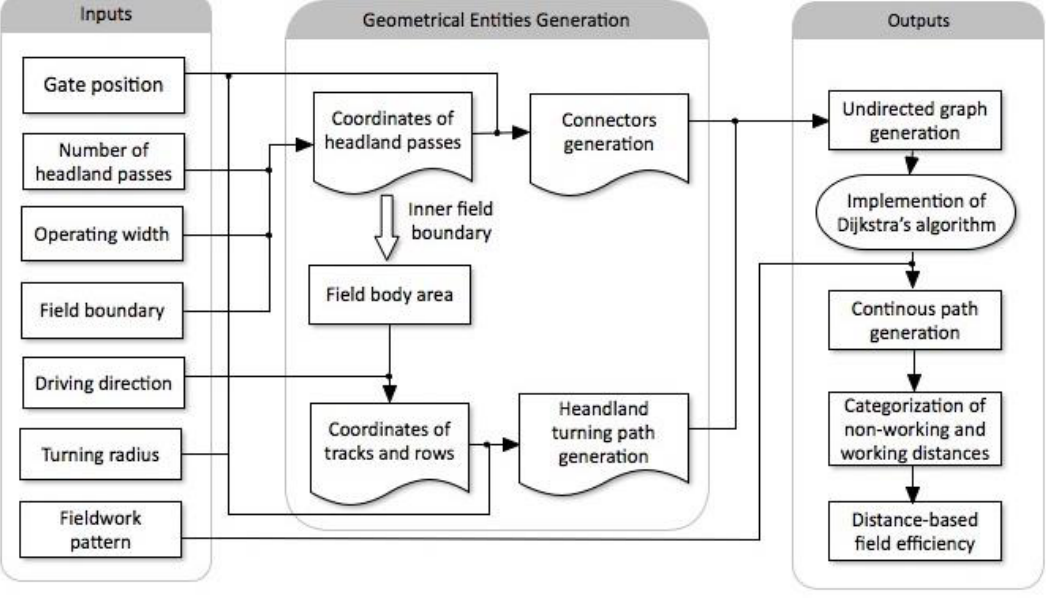
Figure 1. The graphical description of the developed tool.